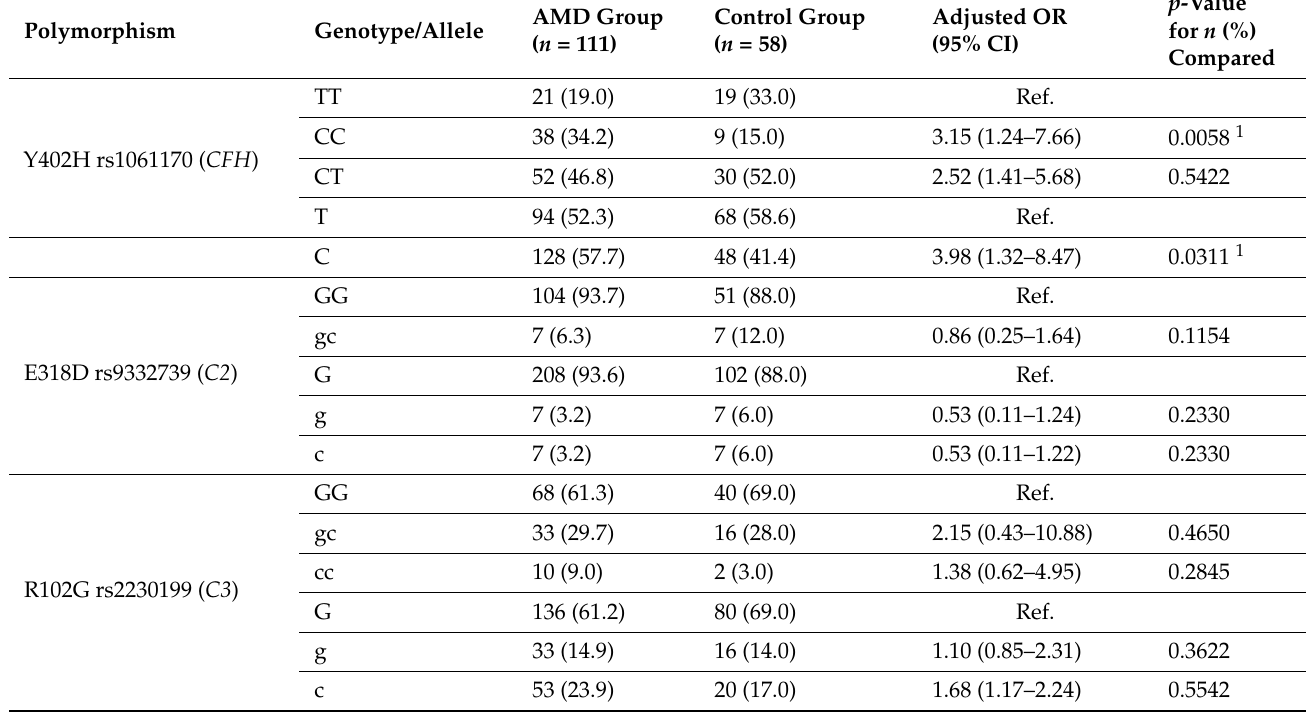
Table 3. Genotype and allele frequencies of polymorphisms in the CFH , C2 , and C3 genes in patients with age-related macular degeneration (AMD) and